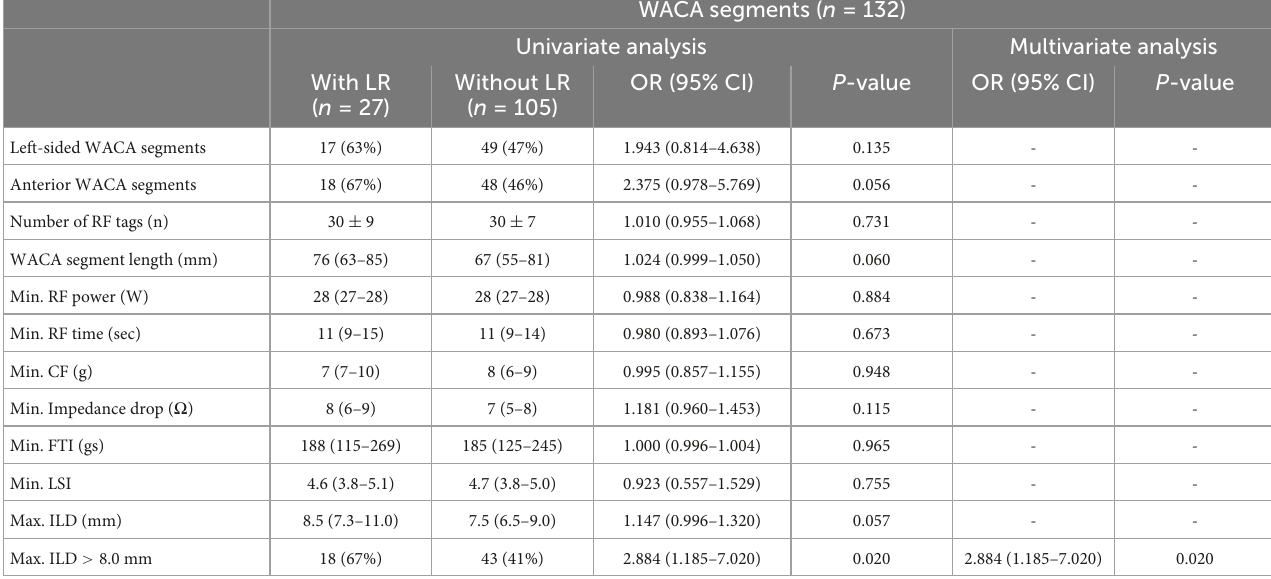
TABLE 3 Risk factors for the WACA segment reconnection.